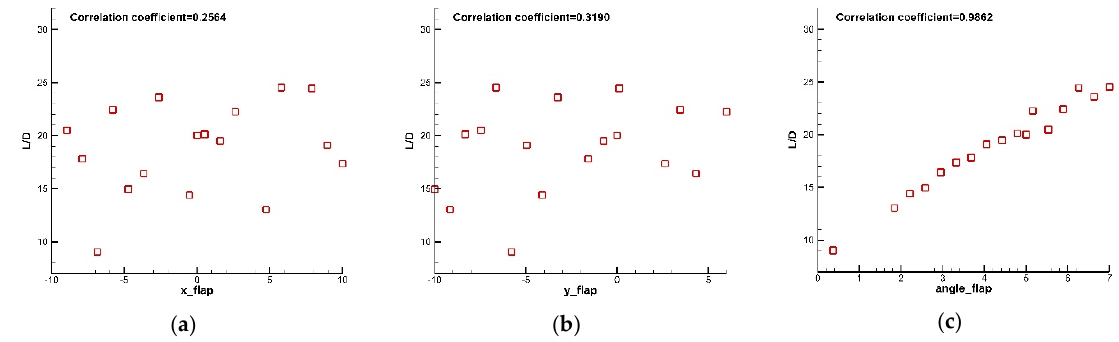
Figure 14. Scatter plots of L/D versus x_flap ( a ); Scatter plots of L/D versus y_flap ( b ) Scatter plots of L/D versus angle_flap ( c ).